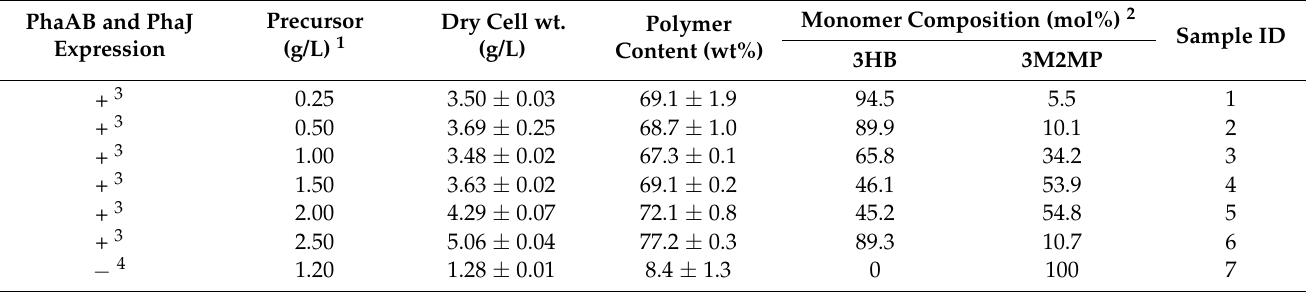
Table 1. P(3HB- co -3M2MP) and P(3M2MP) biosynthesis by recombinant E. coli